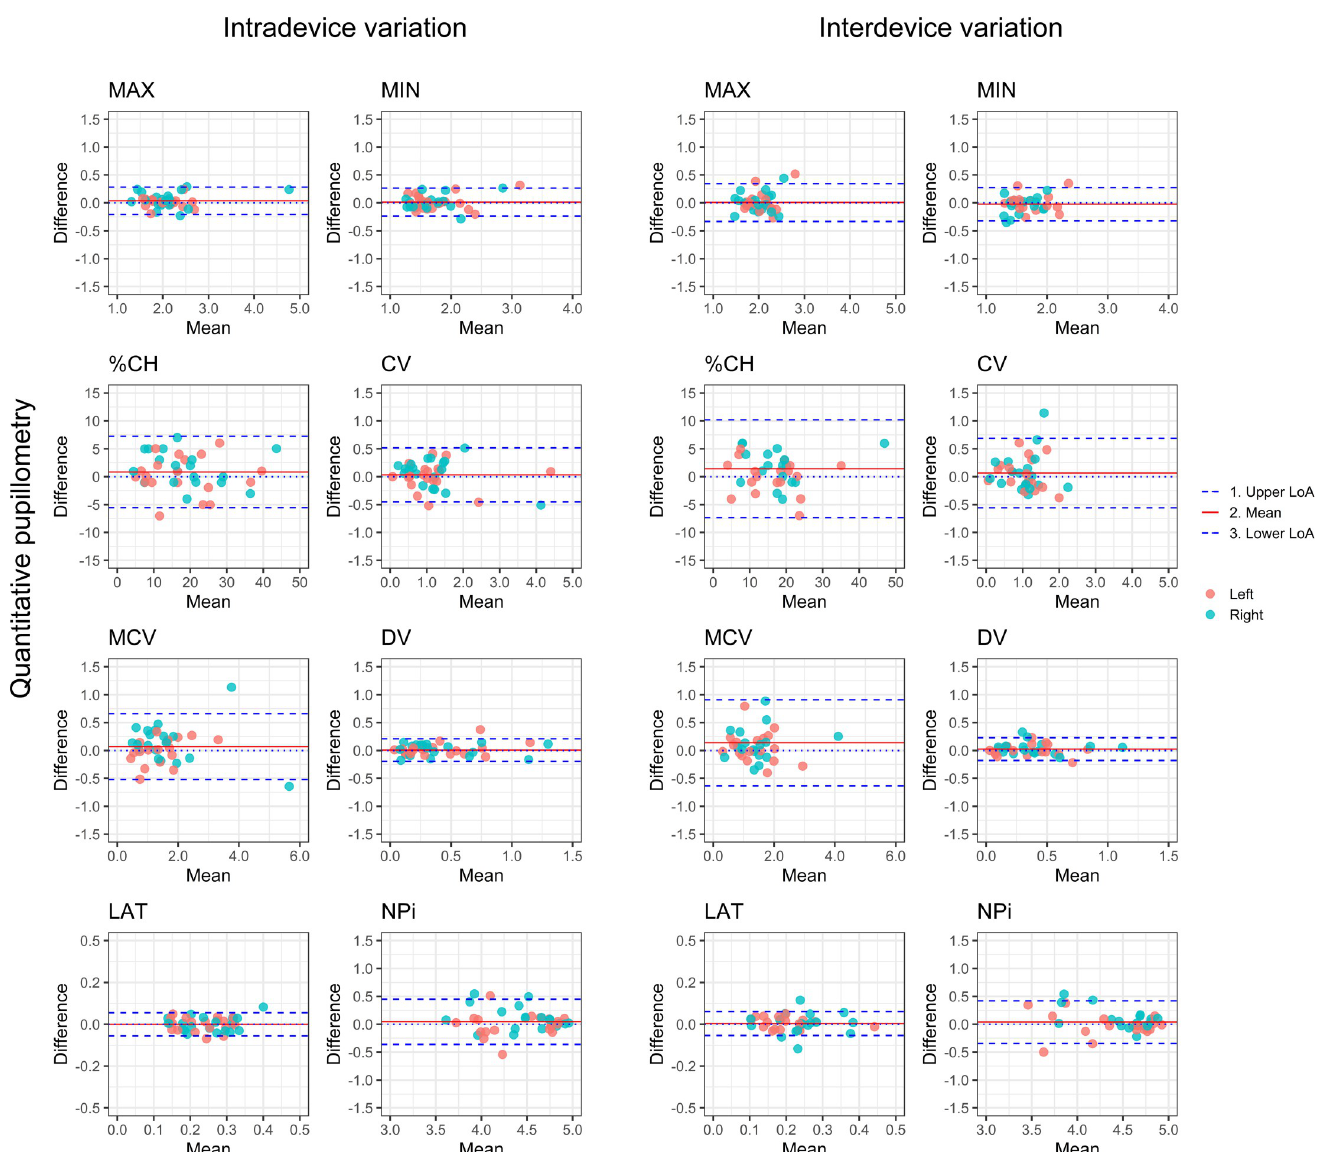
Fig 4. Device reproducibility and repeatability. Bland Altman plots depicting intra-, and inter-device variability of quantitative pupillometry. MAX size = maximum pupillary diameter, MIN size = minimum pupillary diameter, %CH = percental change, CV = average constriction velocity, MCV = maximum constriction velocity, DV = dilation velocity, LAT = latency of constriction, NPi = Neurological Pupil index, LoA = limit of agreement.